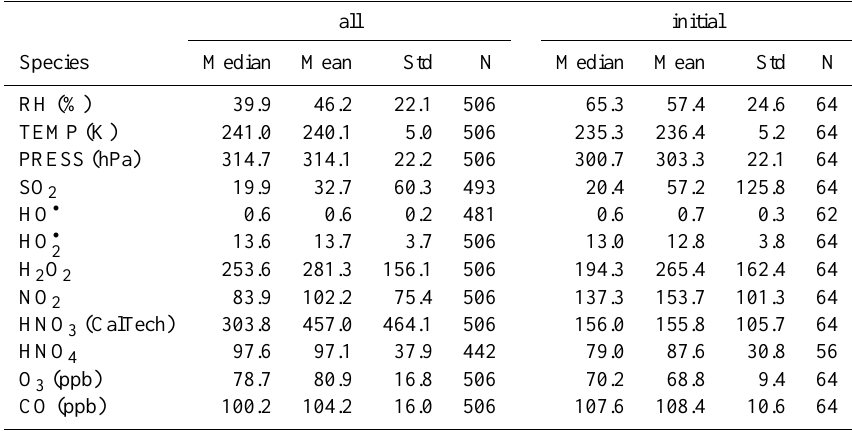
Table A1. Summary of inorganic observations and environmental conditions, from 8 to 10 km, used for evaluation (all) and for initialization (initial, i.e., samples with the highest 12.5% XNO 2 to HNO 3 ratios) from the INTEX-A observational campaign. Unless otherwise noted, values are in parts per trillion (ppt).